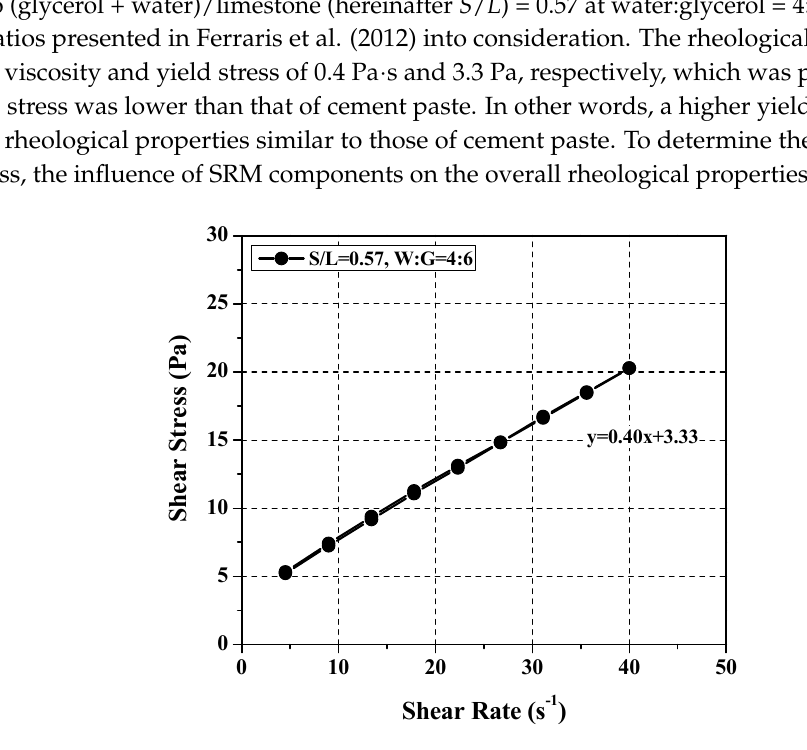
Figure 4. Test results of rheology for the initial condition.